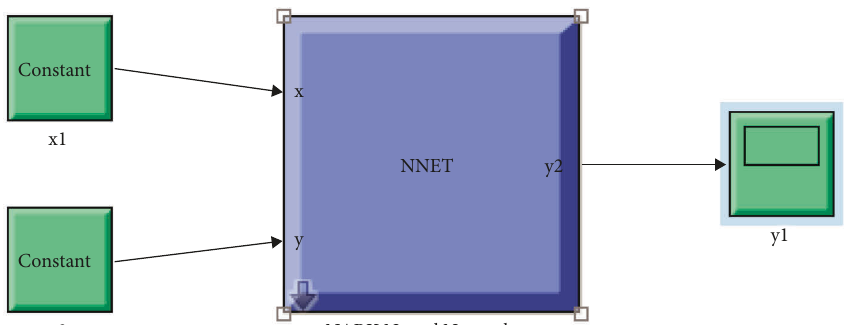
Figure 4: Simulink diagram.